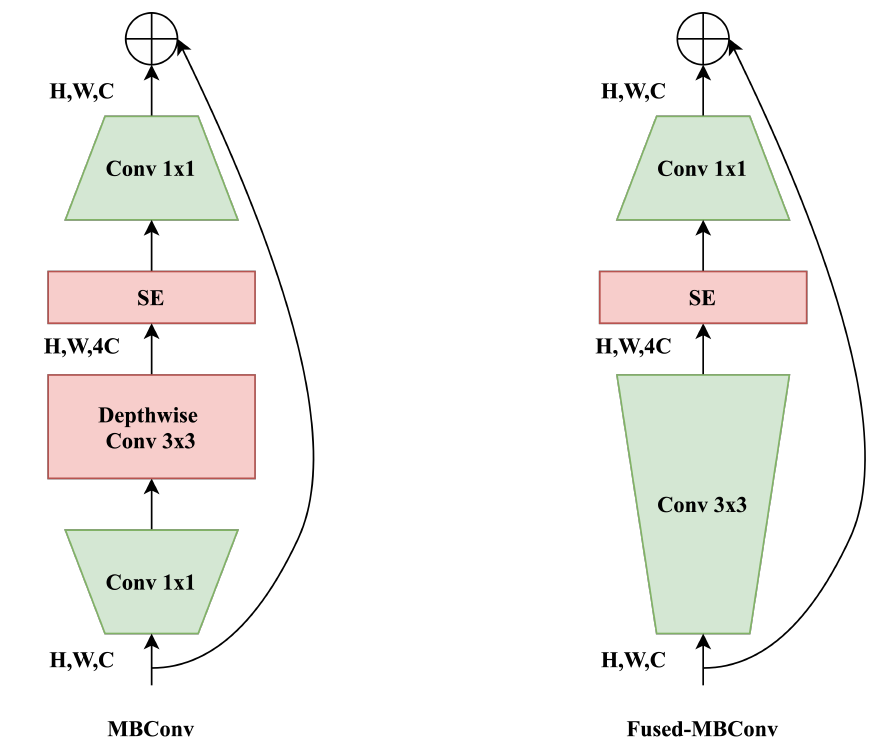
Figure 3. MBConv and fused-MBConv blocks extensively utilized by EfficientNetV2 CNNs. Fused- MBConv blocks are recently proposed for better utilization of mobile or server accelerators. This replaces depthwise and expansion convolutional layers in MBConv with a single regular convolu- tional layer. Replacing MBConv with fused-MBConv can improve model training speed with small memory